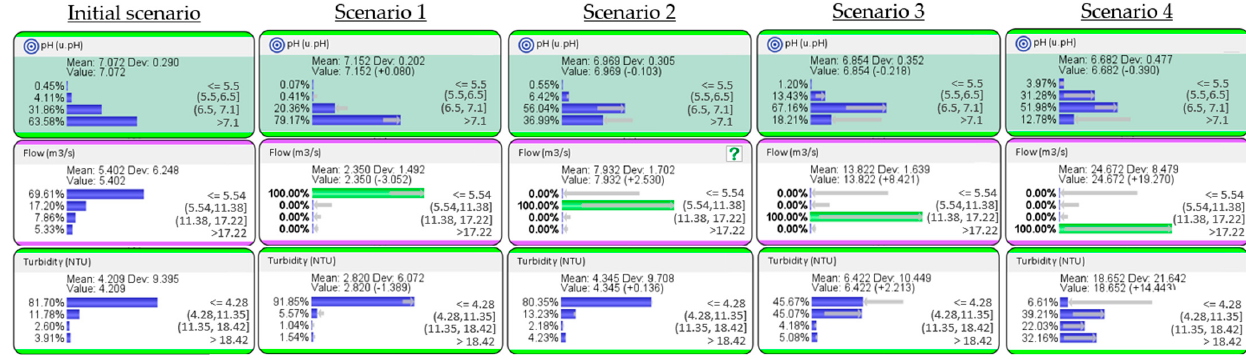
Figure 8. Risk assessment of an increase in the fl ow of the Cúa River on the pH and turbidity varia- bles. The percentage distribution of the variables before the inferential analysis is based on an initial scenario where the average behavior of the river is re fl ected. The four ranges of pH, fl ow, and tur- bidity are those obtained from the control graphs 𝑥̅ .